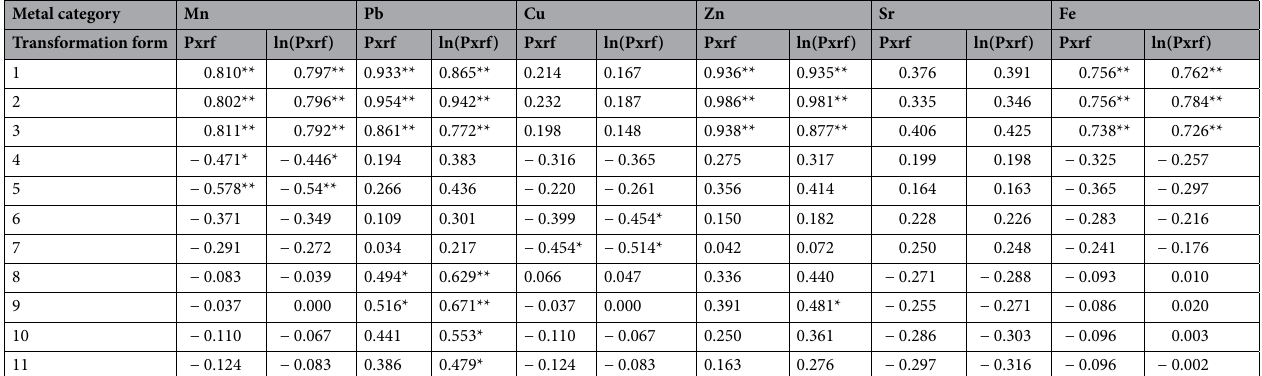
Table 3. Correlation coefficients of Pxrf content of metals and related factors. 1 2, and 3 indicate the original value of ICP-MS, logarithmic transformation, and squared transformation, respectively; 4, 5, 6, and 7 represent the original value of water content, logarithmic transformation, square transformation, and cubic transformation, respectively; 8, 9, 10, and 11 represent the original value of organic matter, logarithmic transformation, square transformation, and cubic transformation, respectively; **indicates 0.01 level (two tailed), the correlation was significant; *indicates 0.05 level (two tailed), the correlation was